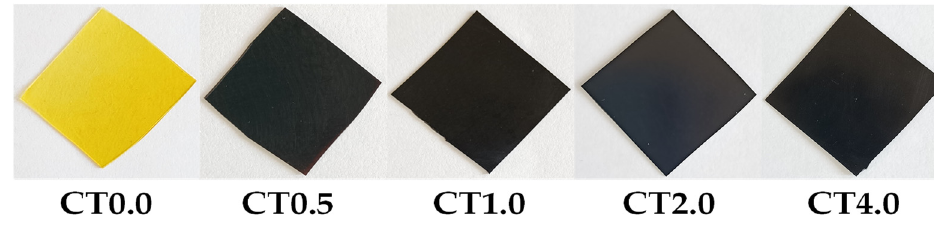
Figure 6. Cured Polyhydroxyurethane–TANI Composites .